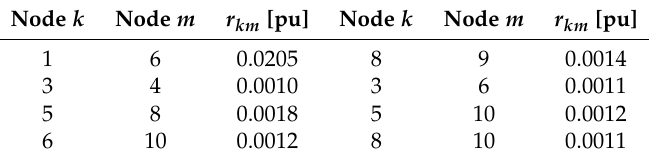
Table 2. Connections proposed for the 10-nodes test